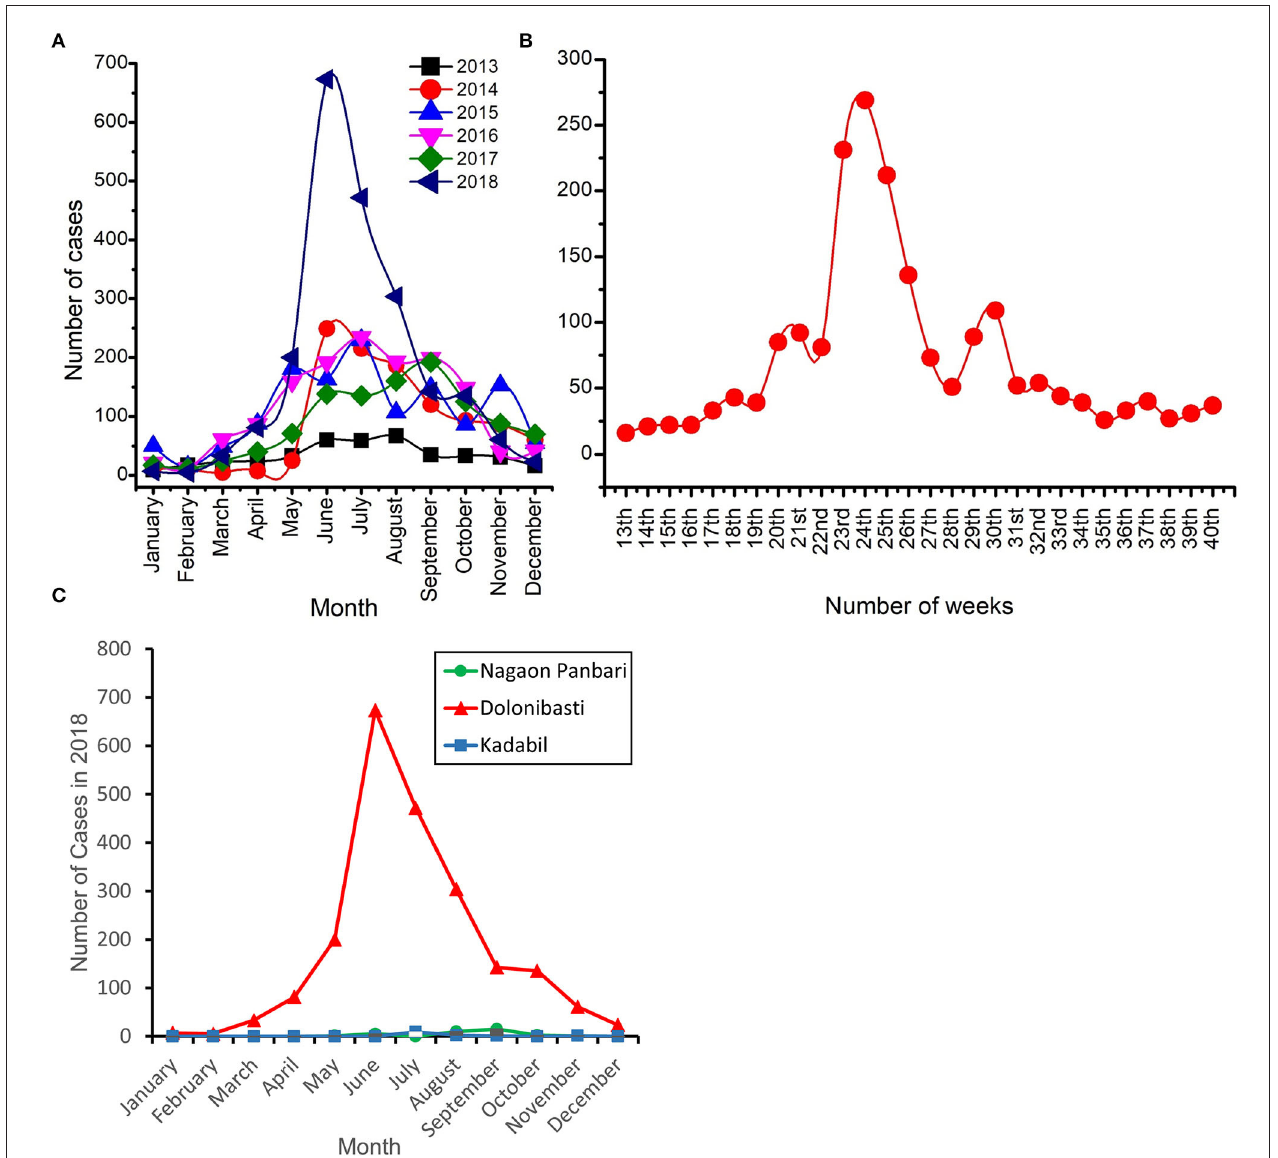
FIGURE 3 | Number of malaria cases reported in the Dolonibasti sub-center and its adjoining two sub-centers of Orang BPHC. (A) Month wise incidence of malaria cases during 2013–18. (B) Weekly incidence of malaria cases during 2018 and (C) Month wise incidence of malaria cases during 2018 in the Dolonibasti sub-center and it’s adjoining two sub-centers namely Nagao Panbari and